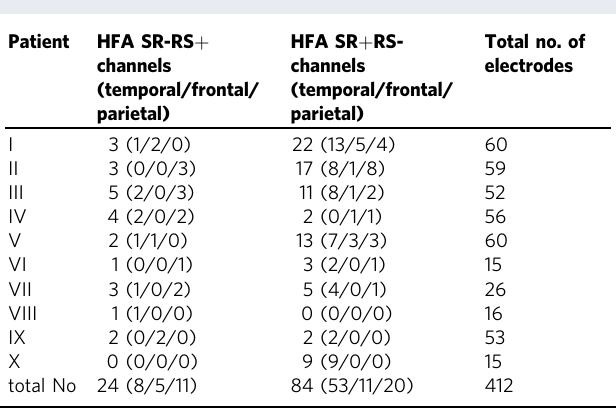
Table 1 Summary of